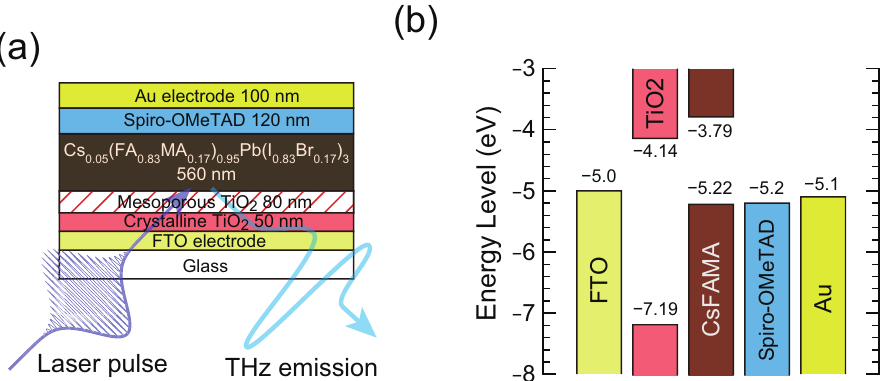
Figure 1. ( a ) Schematic of the perovskite solar cell sample and ( b ) energy level diagram of the sample. The excitation light pulses are absorbed in the perovskite layer near the interface between the perovskite layer and TiO 2 electron transport